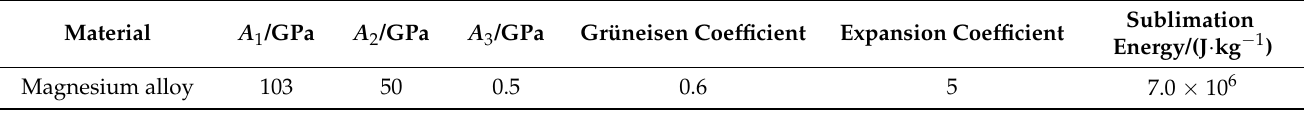
Table 3. Parameters of Puff state equation for magnesium.